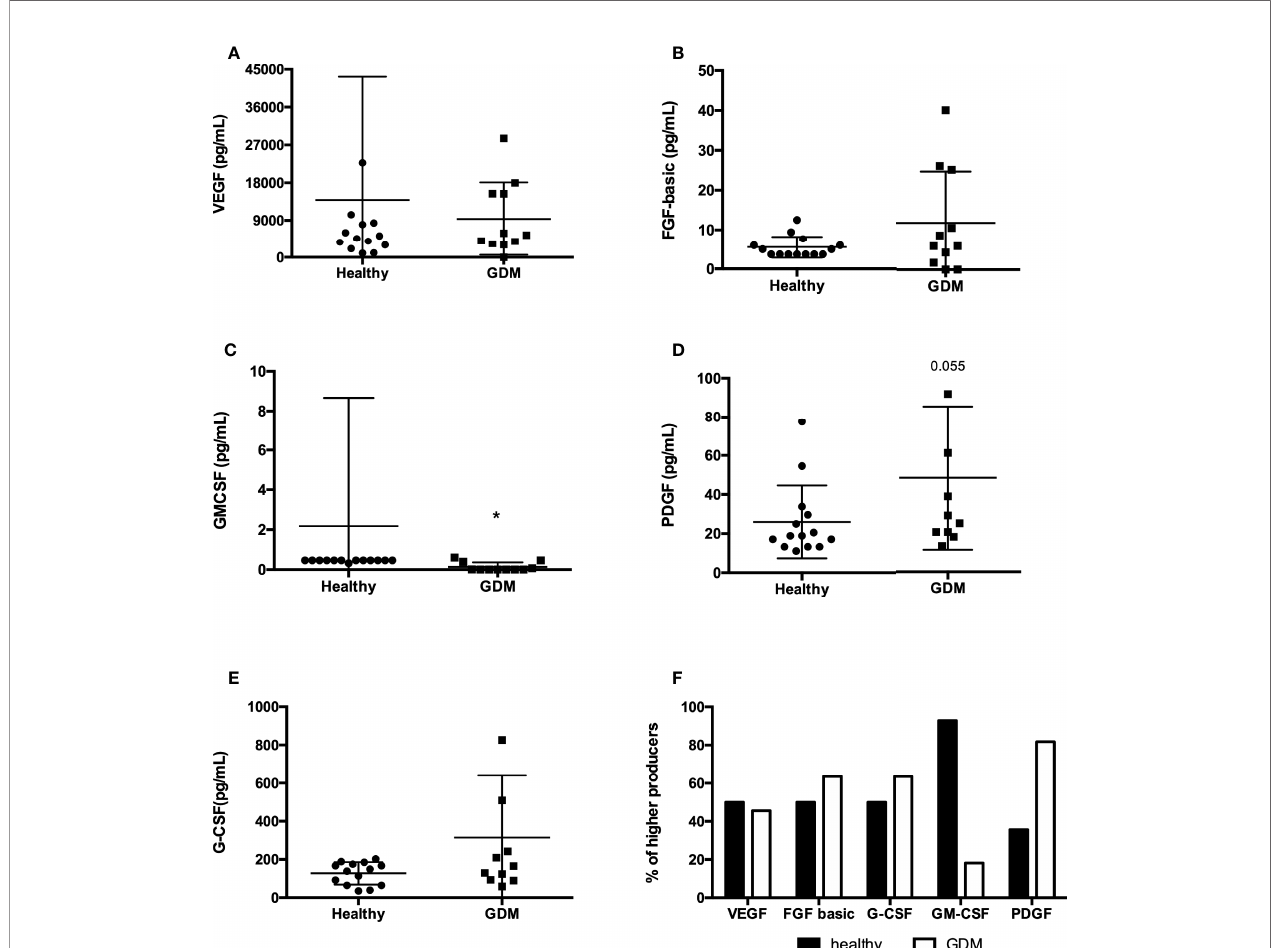
FIGURE 2 | Concentration of growth factors in colostrum comparing healthy mothers with GDM. The concentrations of growth factors were measured in colostrum by Luminex. The circles represent women classi fi ed as having a usual gestational risk. The squares represent women with GDM. A total of 25 samples were included in the analyses. Each geometric fi gure represents a participant. (A) VEF, (B) FGF-basic, (C) GM-CSF, (D) PDGF, (E) G-CSF; * p < 0.05. (F) Frequency of high producers of growth factors in